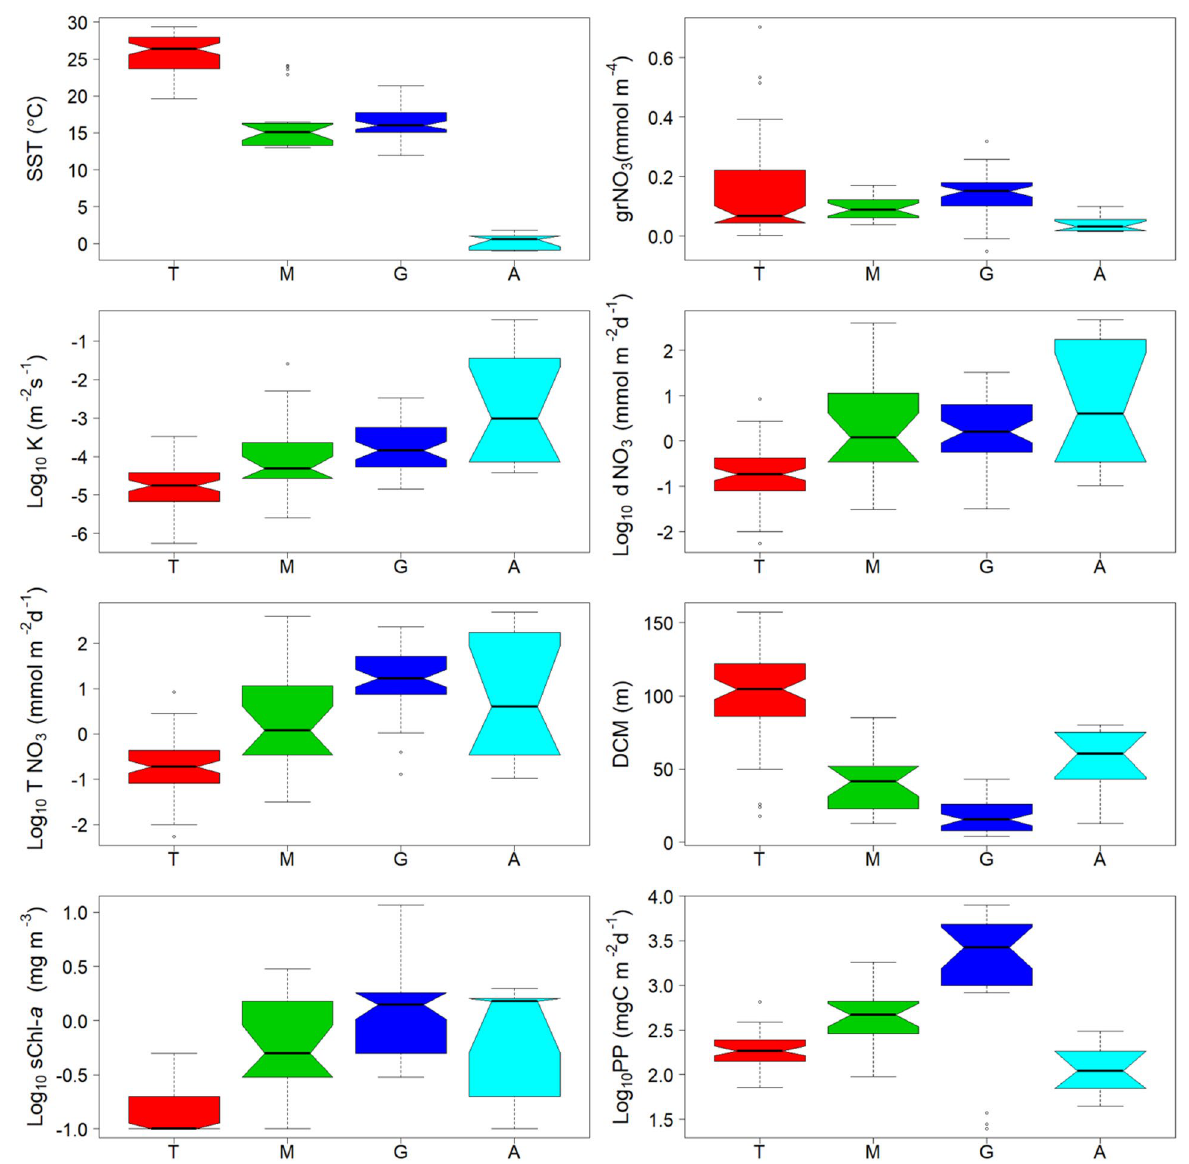
Figure 2. Box-and-whisker plots of Sea surface temperature (SST), vertical nitrate gradient (grNO 3 ), vertical diffusivity (K), nitrate diffusive flux (dNO 3 ), total nitrate supply (including vertical diffusion plus advection, TNO 3 ), depth of the deep chlorophyll maximum (DCM), surface chlorophyll-a (sChl-a), and photic layer depth- integrated net primary production (PP) computed for the tropical and subtropical regions (T), the Northwestern Mediterranean (M), the Galician coastal upwelling (G) and the Antarctic (A). On each box, the central mark indicates the median, the notches the 95% confidence interval for the median, and the bottom and top edges of the box indicate the 25th and 75th percentiles, respectively. The whiskers extend to the most extreme data points not considered outliers, and the outliers are plotted individually using white